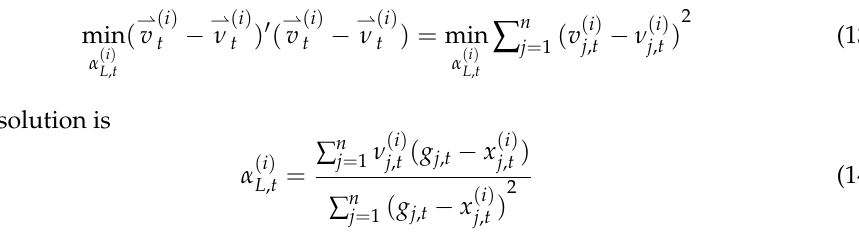
Table 3. Follow the leader when all firms have the same leader in the same year (e.g., α L , t ). Patent Class